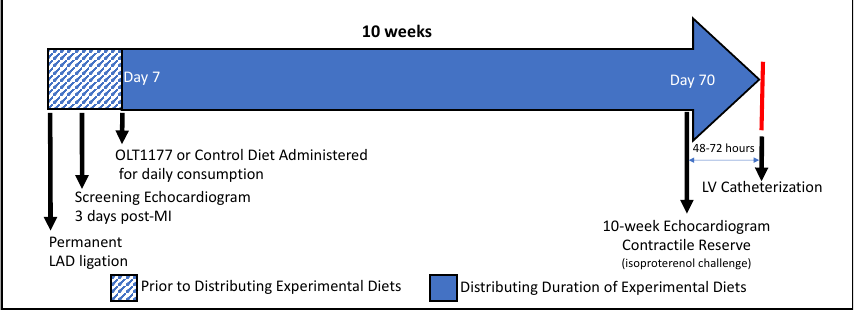
Figure 6. The study was designed to assess cardiac function and contractile reserve following an experimental murine model of the ligation of the left coronary artery without reperfusion in mice consuming an OLT1177-enriched diet. (1) Three days after MI surgery, all of the mice underwent transthoracic echocardiography and were randomly assigned into four groups. (2) After their recovery from the surgery, the four groups of mice were administered either a standard diet or an OLT1177-enriched diet (3.75 g/kg or 7.50 g/kg). (3) Seventy days post-MI, the effects of OLT1177 on cardiac function and contractile reserve were assessed via echocardiography and isoproterenol challenge. (4) About 2–3 days after the 10-week echocardiography and contractile reserve assessments, the diastolic function of all of the surviving mice was assessed via LV catheterization. Abbreviations: LAD = left anterior descending coronary artery; AMI = acute myocardial infarction; SD = standard diet; LV = left